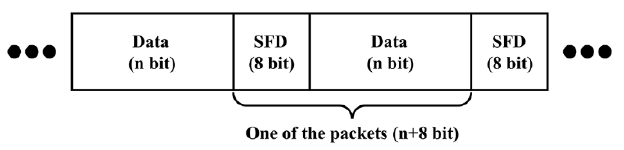
Figure 5. The structure of the packet.